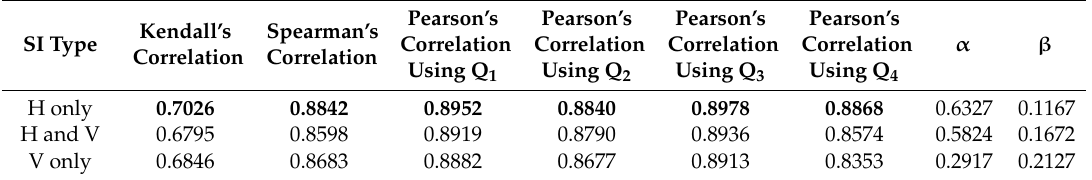
Table 5. Kendall’s, Spearman’s, and Pearson’s correlation for the overall mobile dataset, di ff erent SI calculations (best values are marked in bold). H: horizontal, V: vertical.